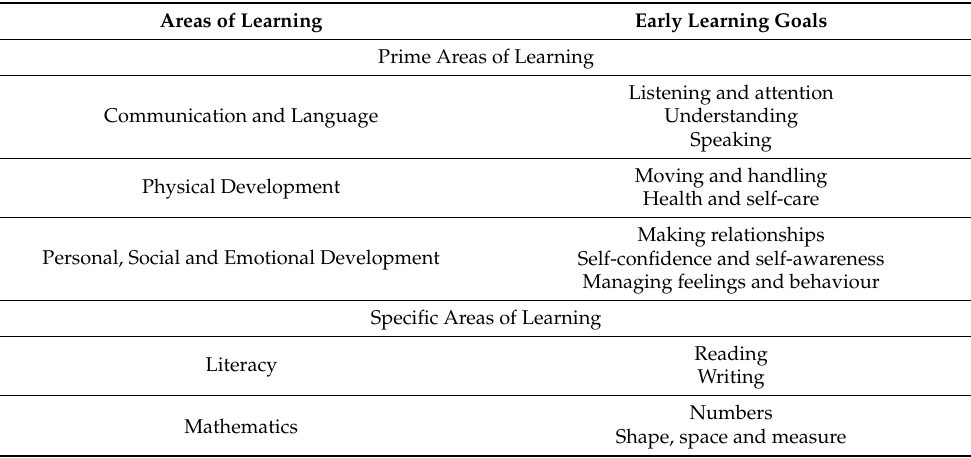
Table 1. EYFSP areas of learning and early learning goals